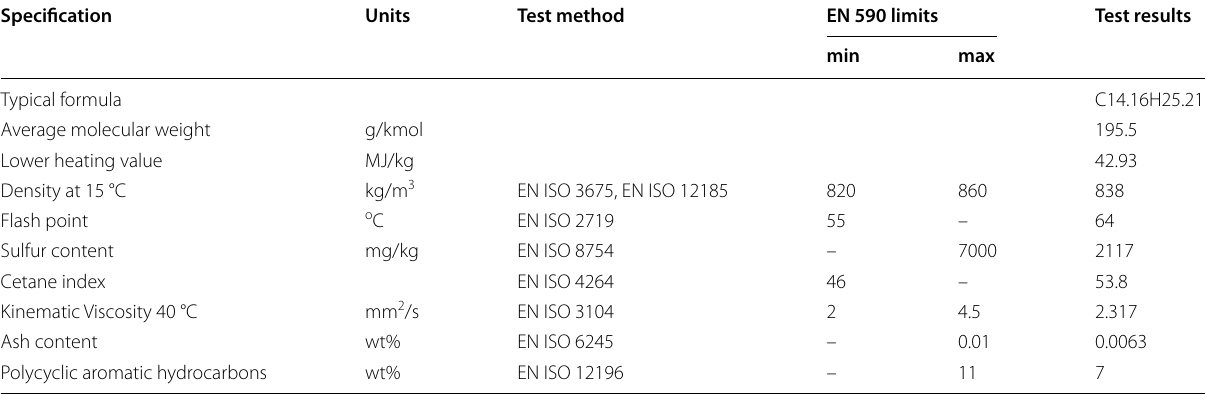
Table 2 Properties of base diesel fuel